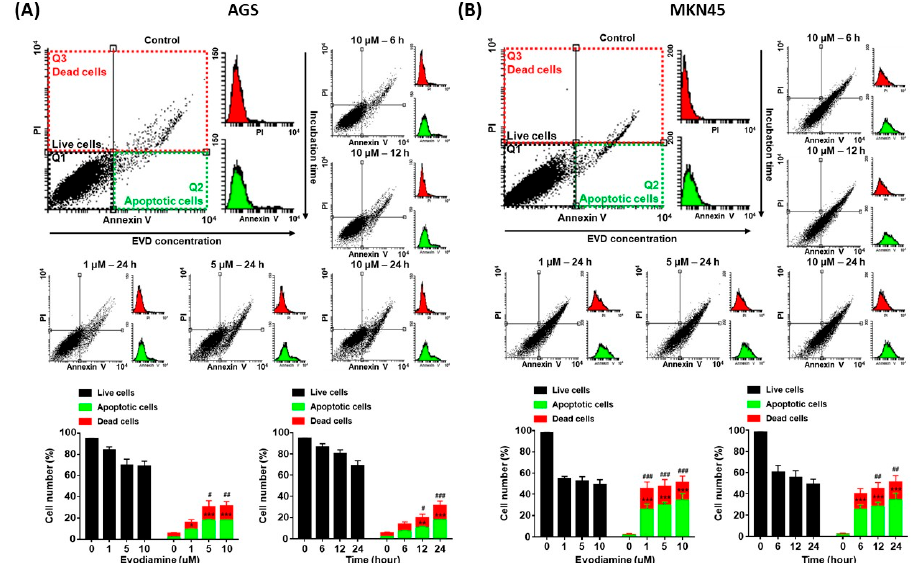
Figure 2. Annexin V and PI staining of AGS and MKN45 cells after evodiamine treatment. ( A ) AGS and ( B ) MKN45 cells were treated with 10 μ M evodiamine for 6, 12, or 24 h and 1, 5, or 10 μ M evodiamine for 24 h, stained with annexin V-FITC and PI, and subjected to flow cytometry. Stained cells were analyzed and illustrated on the quadrant by CellQuestPro software. Percentage of cells in apoptosis was analyzed and illustrated as a graph. Data are presented as the mean ± SEM. * p < 0.05, ** p < 0.01, and *** p < 0.001 vs. the apoptotic cells control; # p < 0.05, ## p < 0.01, and ### p < 0.001 vs. the dead cells control. EVD, evodiamine.